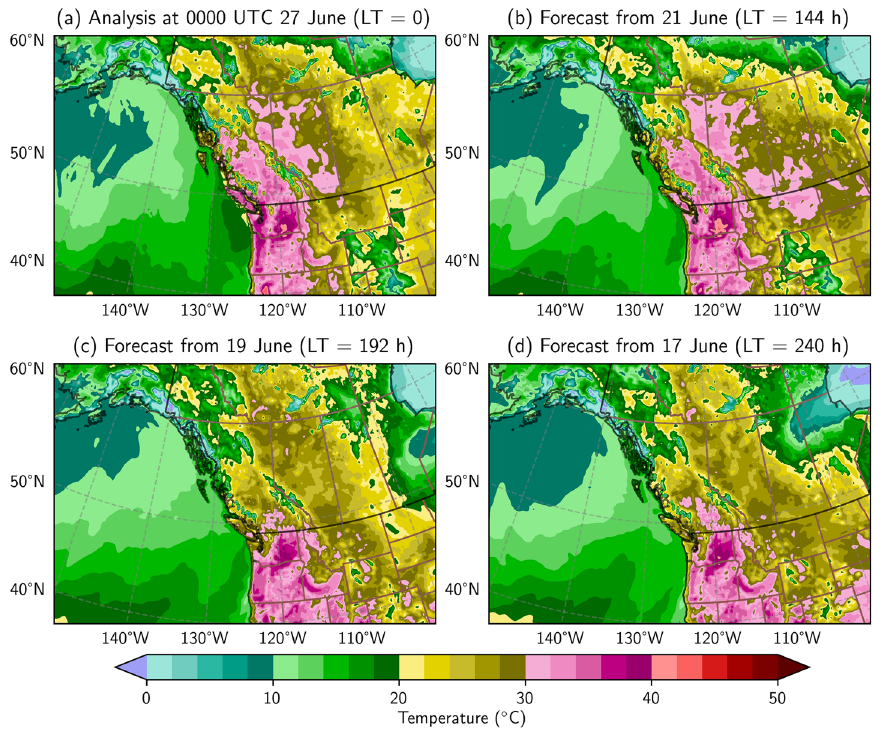
Fig. 9 Distributions of the 2 m temperature valid at 0000 UTC 27 June 2021 based on the Canadian GDPS operational outputs. a The GDPS analysis. b – d The GDPS predictions with different lead times